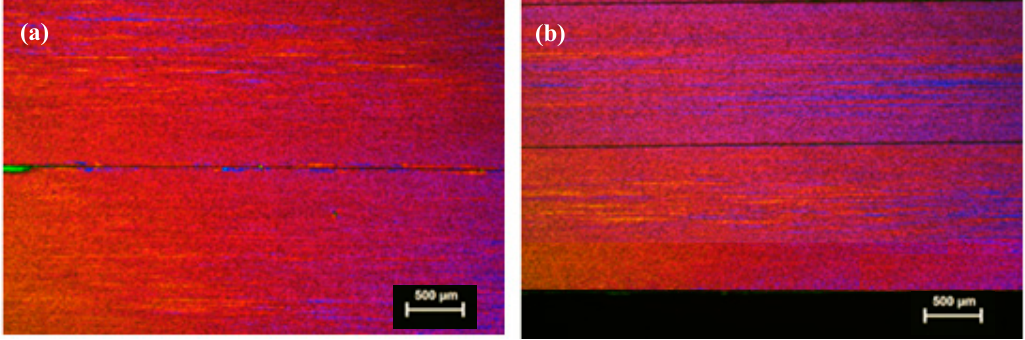
Figure 7. Micrographs planks extruded from non-homogenized MC-DC of TT-6111 (3) billet with cold rolling in longitudinal (Top) and transverse (bottom) directions; ( a ) cold rolling of annealed 3 mm planks to 1.7 mm and ( b ) cold rolling of 1.7 mm planks to 1.0 mm.